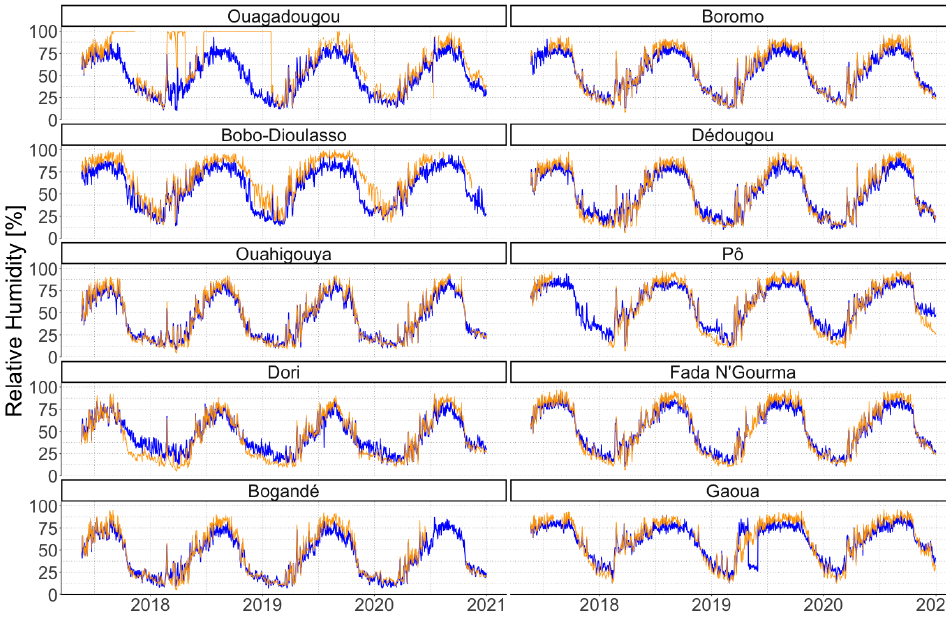
Figure 14. Comparison of relative humidity time series between TAHMO stations in orange and the corresponding stations from meteorological service of Burkina Faso in blue.